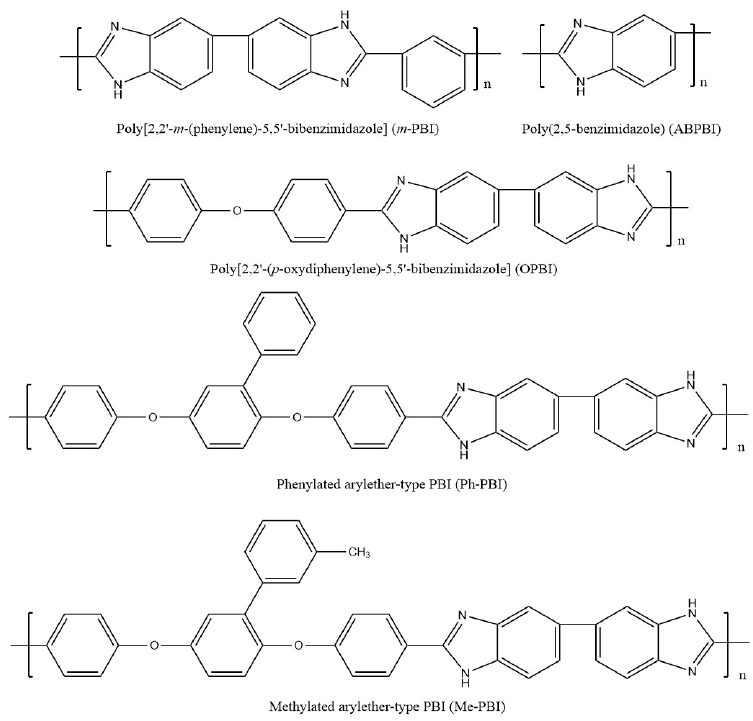
Figure 2. Chemical structure of some